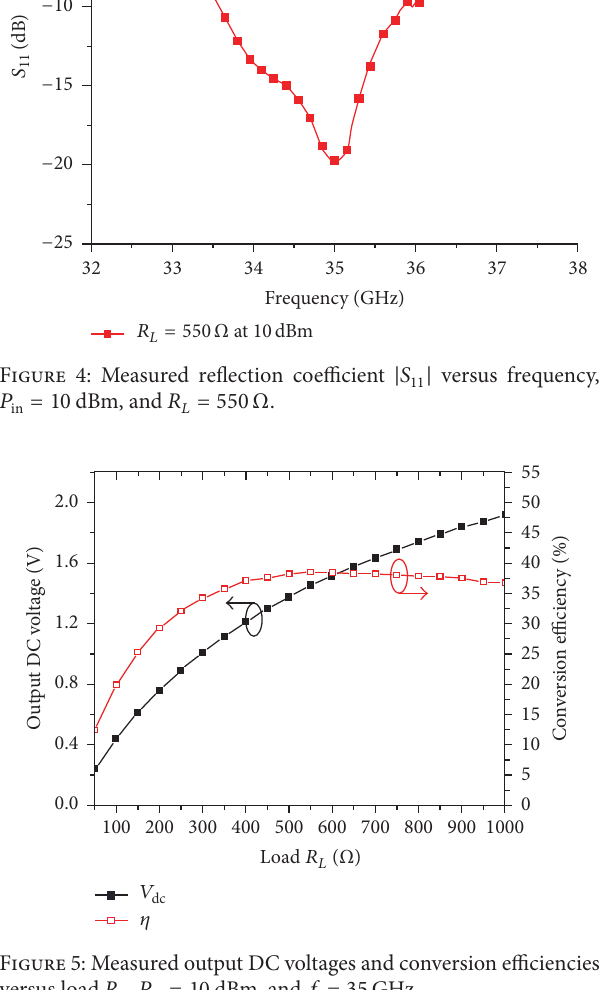
Figure 5: Measured output DC voltages and conversion efficiencies versus load 𝑅 𝐿 , 𝑃 in = 10 dBm, and 𝑓 = 35 GHz.